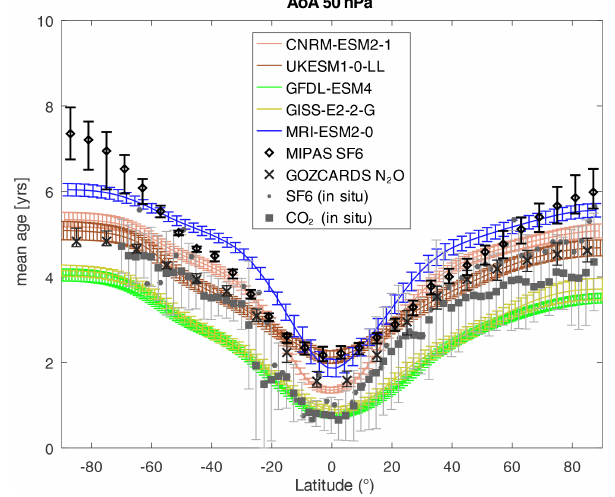
Figure 3. Annual-mean AoA at 50hPa for historical simulations av- eraged over 1990–2014, including the standard deviation of the an- nual means. Observationally derived AoA values are shown based on SF 6 measurements by MIPAS from 2005–2011 (Stiller et al., 2020) and N 2 O measurements from the GOZCARDS data set for 2004–2012 (Linz et al., 2017). For both, vertical bars represent the spread between minimum to maximum annual-mean values. In ad- dition, AoA values are shown as derived from in situ measurements of SF 6 and CO 2 by Andrews et al. (2001). The error bars for the in situ measurements represent uncertainty in the measurement and derivation of AoA rather than interannual